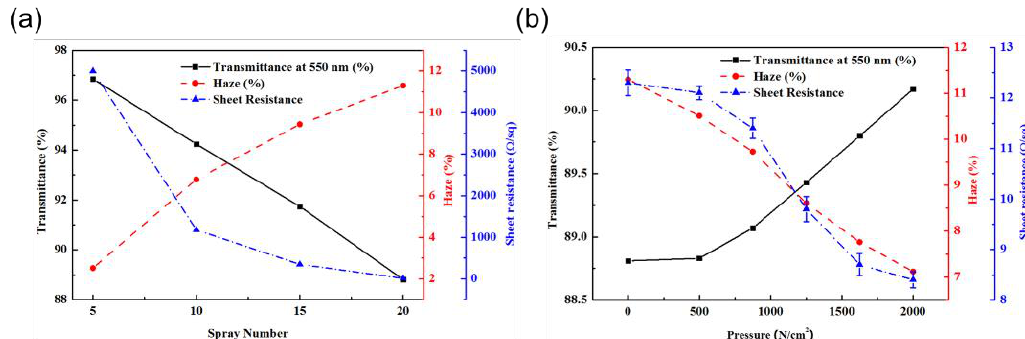
Figure 2. Change in optical transmittance at 550 nm, haze, and sheet resistance: ( a ) as a function of the number of AgNW spray coatings before mechanical welding by pressurizing the AgNW network on the polymethyl methacrylate (PMMA) / SiO 2 substrate measured; ( b ) as a function of the pressure for the mechanical welding of the AgNW in ( a ) with 20 sprayings.